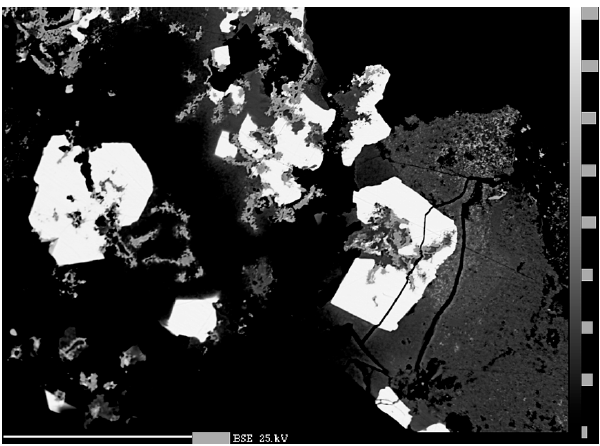
Figure 26. Euhedral clausthalite grains (white) in non-homogenous Cu-Sb oxide (dark grey). BSE photo. P ř íbram, a dump of shaft 16. Photo by J. Sejkora and P. Škácha. In reflected light, clausthalite is white and isotropic.